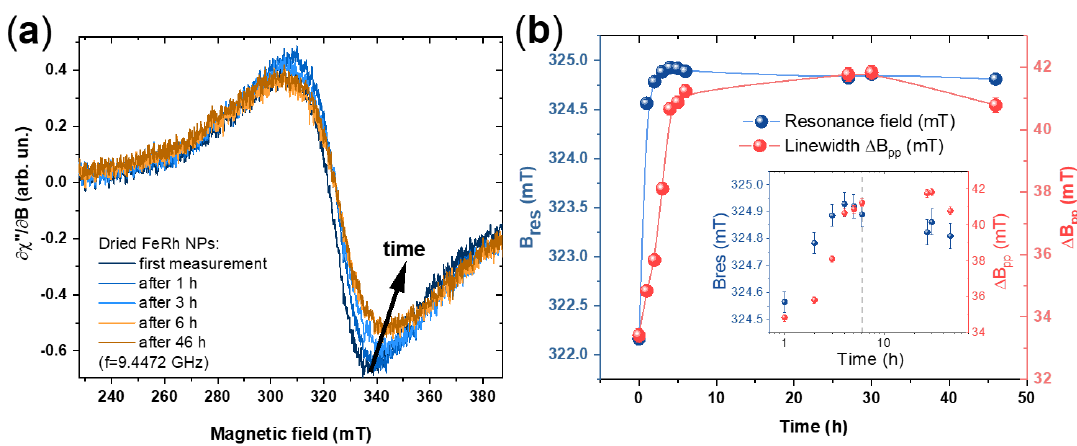
Figure 8. ( a ) Evolution of FMR spectra for Fe 50 Rh 50 nanoparticles during 46 h after drying; ( b ) time dependence of the corresponding resonance field and linewidth. Inset shows the data in logarithmic time scale, dot line marks 6 h.